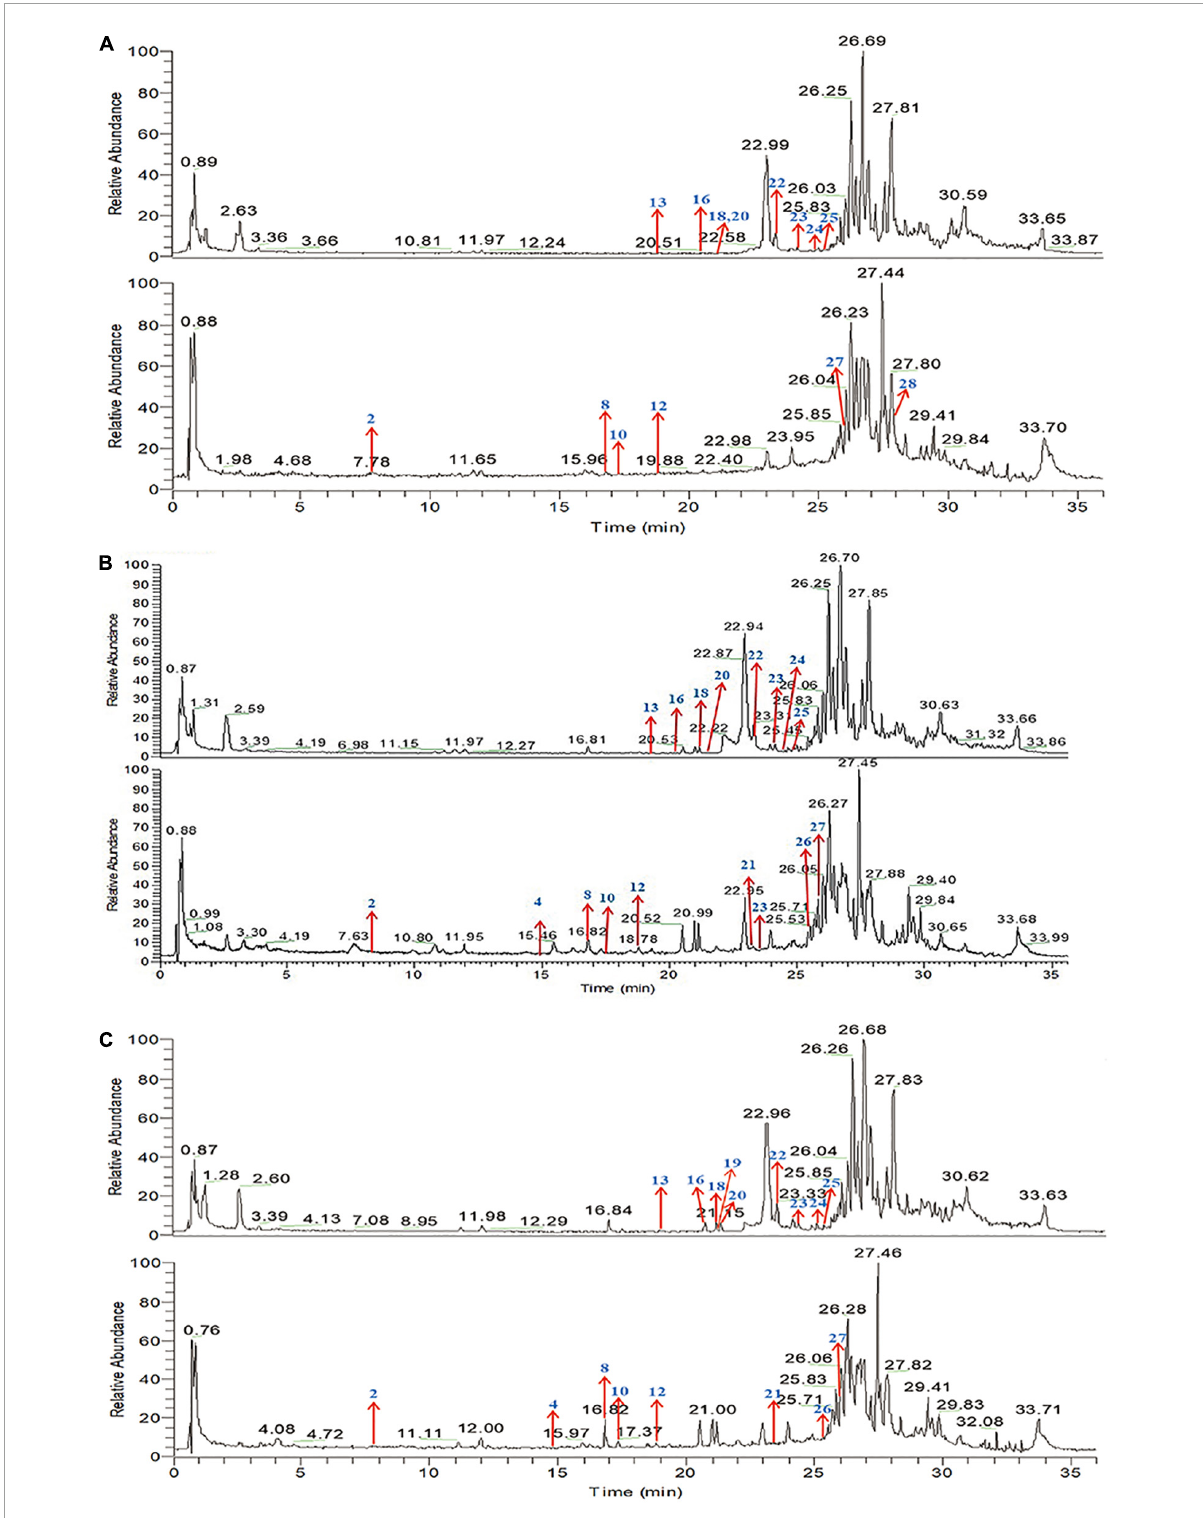
FIGURE1 Total ion chromatogram (TIC) in positive ion mode and negative ion mode by UPLC-MS/MS. (A) Sample-30 min. (B) Sample-60 min. (C) Sample-90